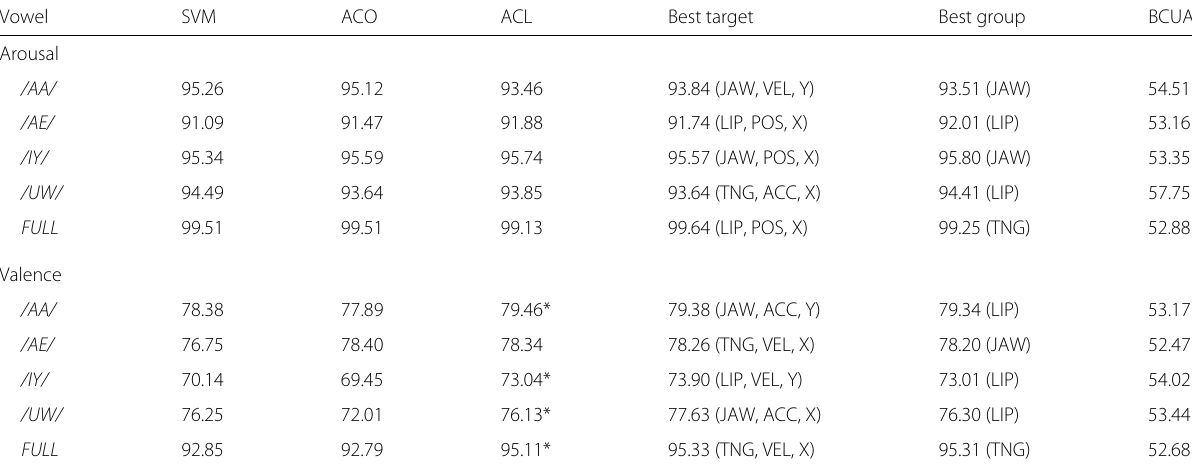
Table 3 Within-corpus results for binary classification on the USC EMA